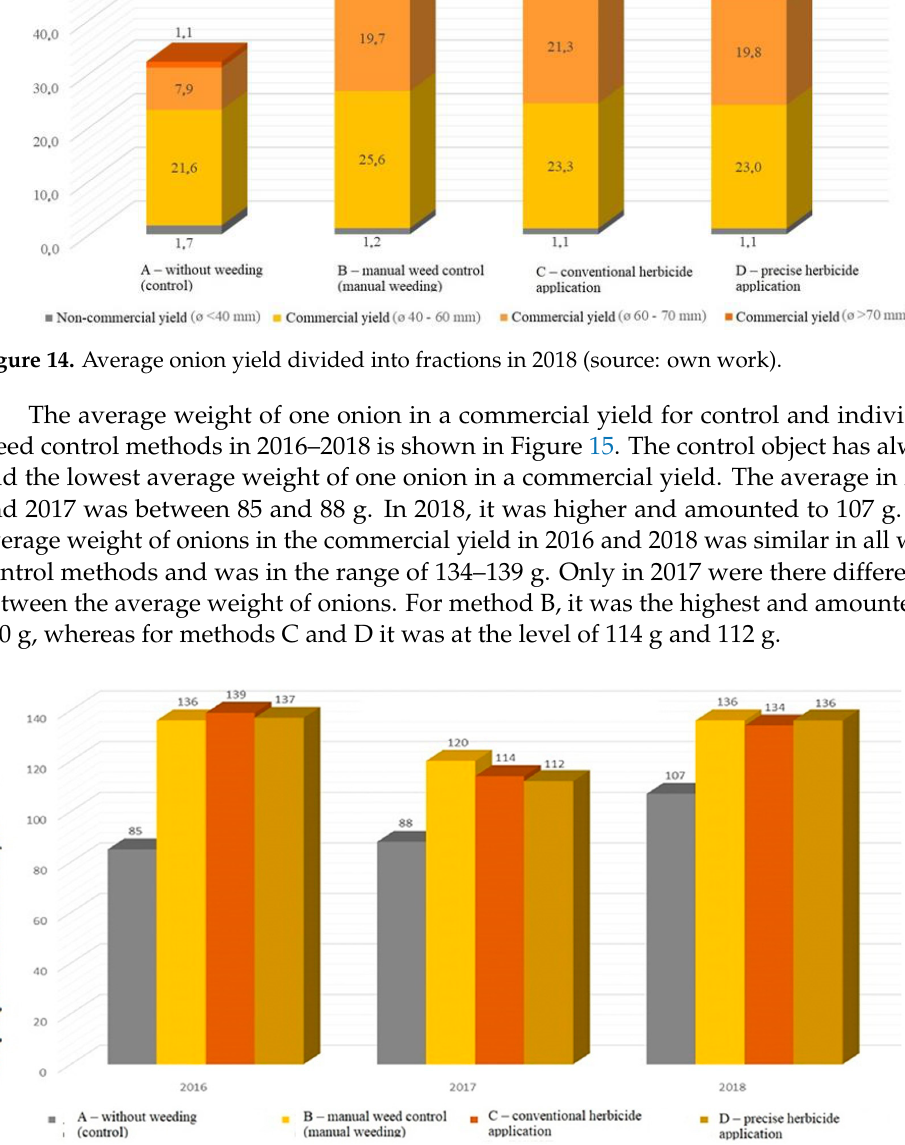
Figure 15. Qualitative assessment of commercial onion yield (ø ≥ 40 mm) in terms of the average weight of one piece 2016–2018 (source: own work).